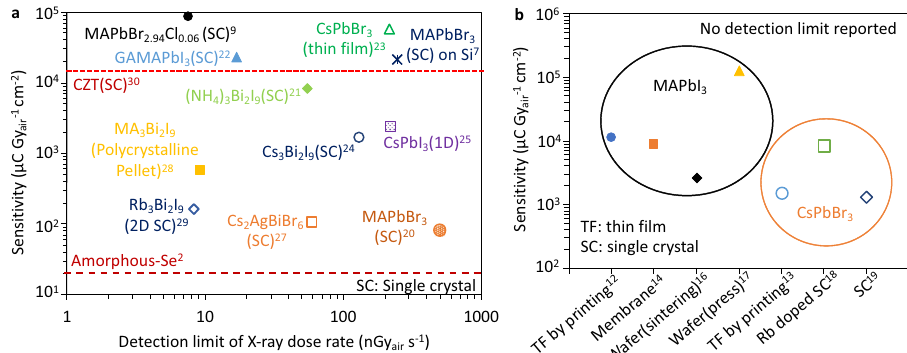
Fig. 1 Detection limit and sensitivity of various perovskite X-ray detectors. a Perovskite X-ray detectors with sensitivity and detection limit reported in the literatures with comparison to amorphous Selenium 2 and Cadmium Zinc Telluride (CZT) 30 . b Sensitivity of MAPbI 3 and all-inorganic CsPbBr 3 X-ray detectors prepared with different material synthesizing methods and device structures where no detection limits are reported. The superscripts stand for the reference